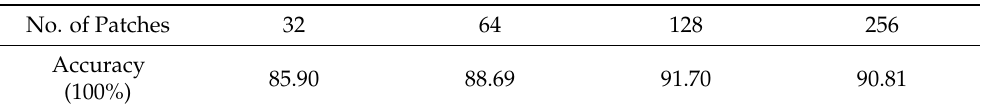
Table 2. Comparison of model level identification accuracy with varying number of training patches per